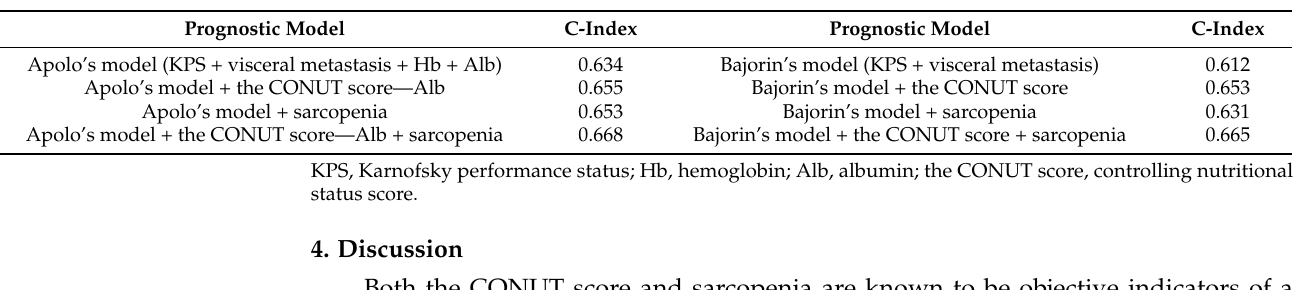
Table 5. C-index of the established prognostic models combined with the controlling nutritional status (CONUT) score or/and